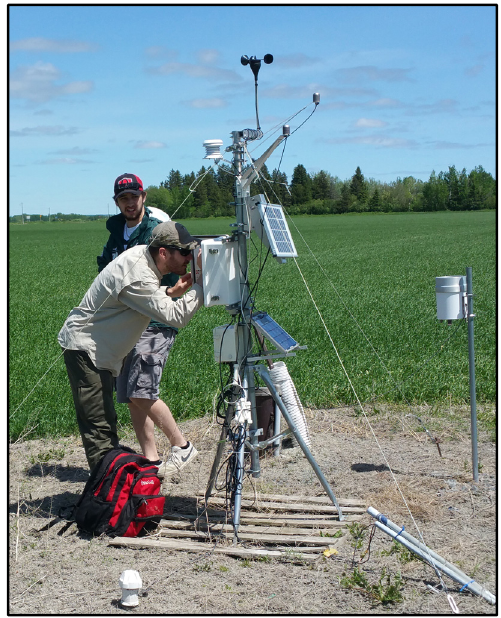
Figure 1. One of the many weather stations maintained for the GeoVisage system. This HOBO U30 station, located in Temiskaming Shores, has been actively collecting data since 3 July 2009.